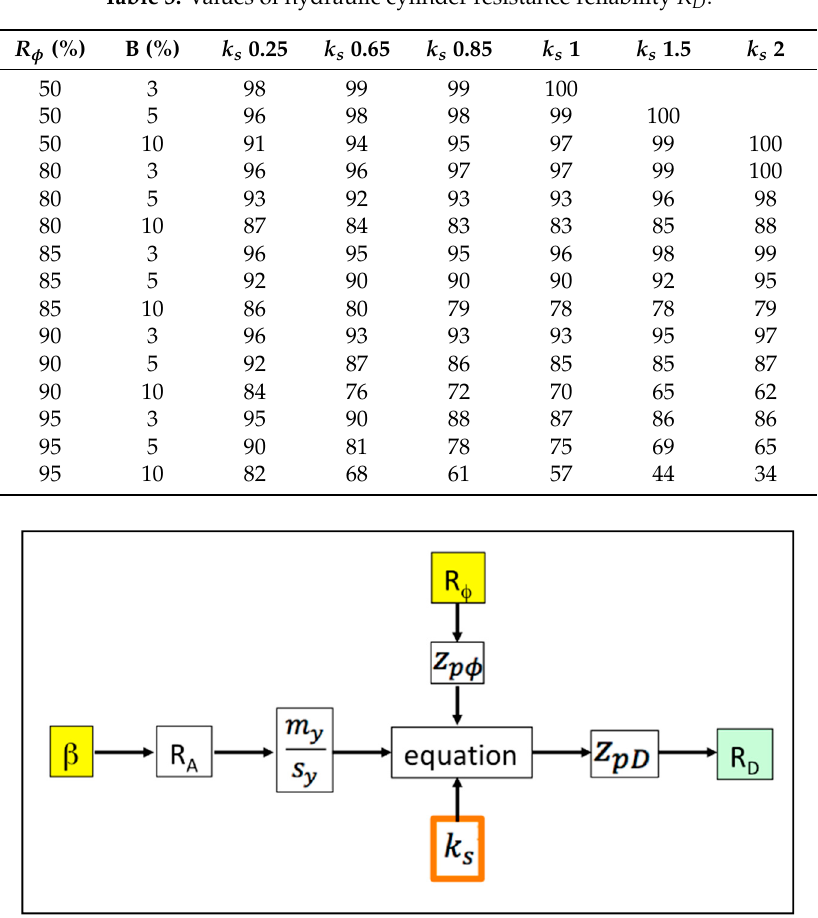
Figure 8. Scheme to calculate the required resistance reliability ( R D ). Table 3. Values of hydraulic cylinder resistance reliability R D .